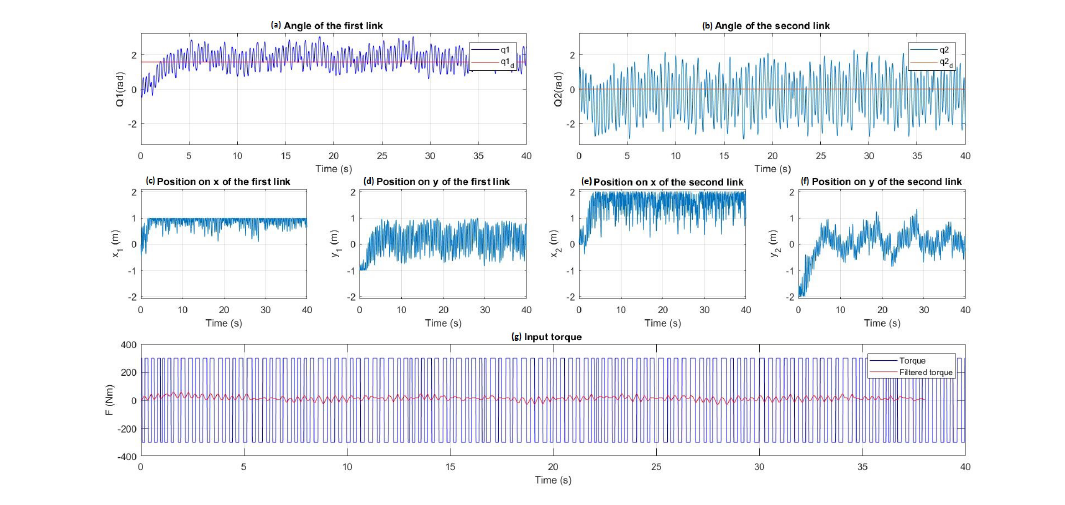
Figure 6. Results of the PWM controller to maintain the acrobot horizontal. In the first row, the positions of the angles of the first ( a ) and the second ( b ) links are shown in radians. The red line in ( a ) is the moment when the balancing controller starts to control for the balancing problem. The red line in ( b ) is the desired angle of the second link. In the second row, there are the positions on x ( c ) and y ( d ) of the first link and on x ( e ) and y ( f ) of the second link. The red lines in ( d ) and ( f ) are the goal height (1 m) of the swing-up problem. In the last row, the input torque is represented ( g ). The task of maintaining the acrobot horizontal is achieved, as shown in the graph of the position on the x axis of the first (Figure 6c) and second (Figure 6e) links. The amplitude of the oscillations can be reduced with a lower time of control, but cannot be